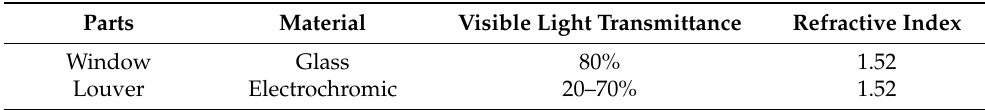
Table 1. Setting the physical properties of the light-transmitting material.